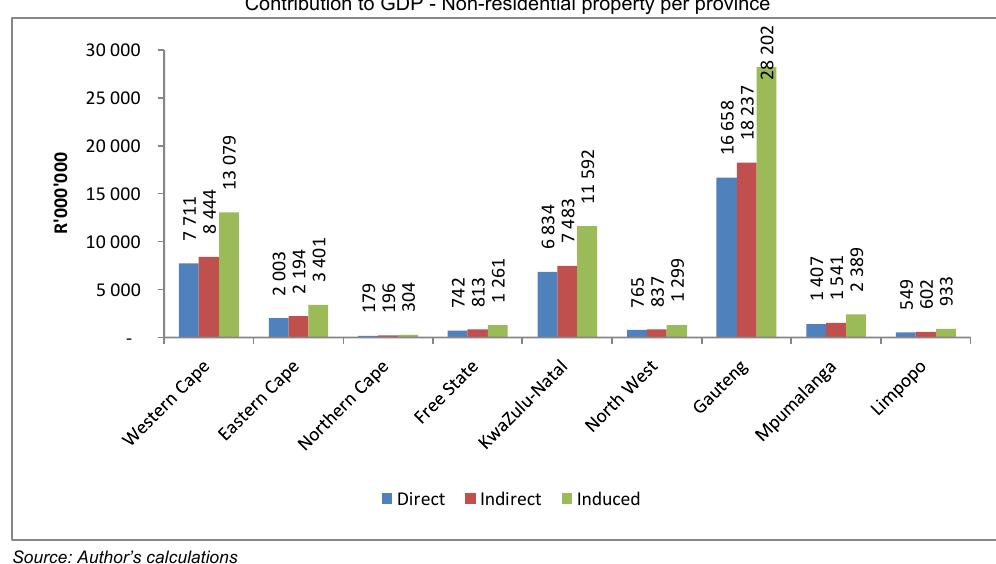
Figure 20 Contribution to GDP - Non-residential property per